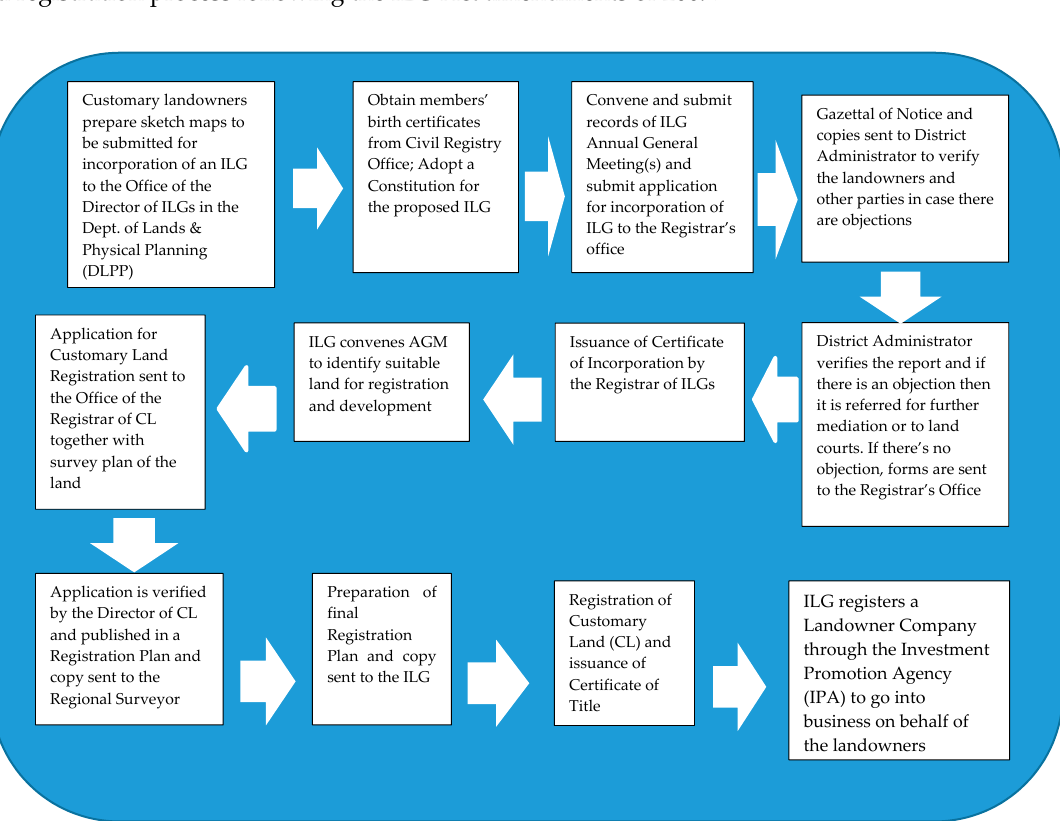
Table 3. Summary of the Sample Population Groups (Landowners and Stakeholders).